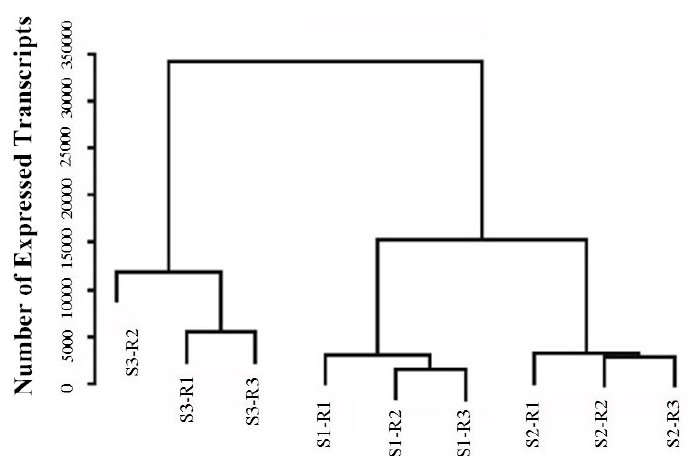
Figure 3. Global analysis of the transcriptome datasets of biological replicates and samples is shown. The dendrogram depicts the global relationships of the samples. The bar plot describes the number of expressed transcripts after filtering.